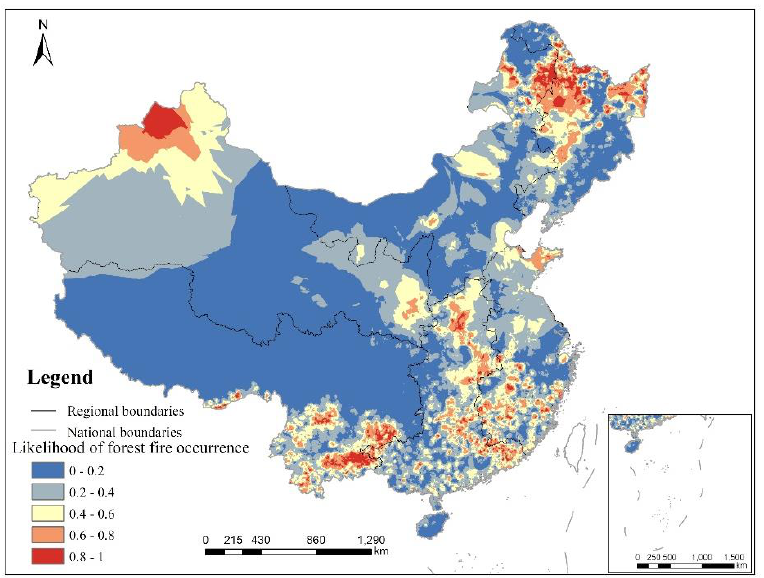
Figure 5. Map of the likelihood of forest fire occurrence in China obtained from the regional models.